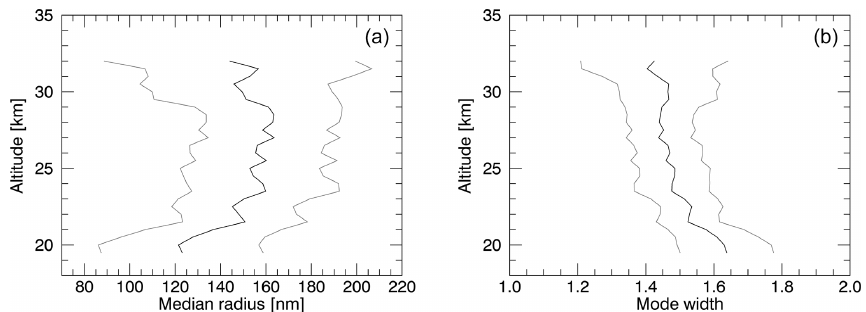
Figure 8. Profiles of median radius (a) and mode width (b) averaged between 2.5 ◦ S and 2.5 ◦ N for the month of June 2017. Grey lines depict total errors as calculated in Sect.